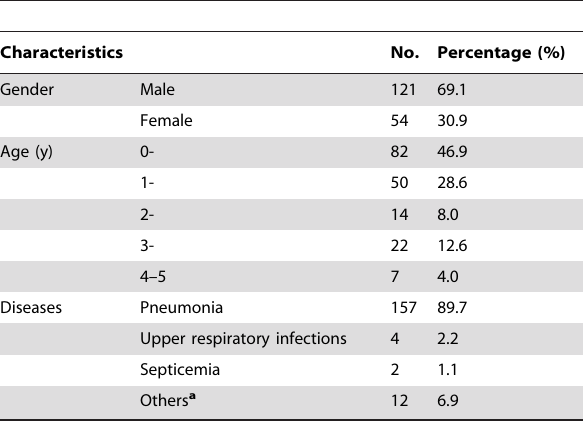
Table 1. The demographic and clinical characteristics of 175 enrolled patients.